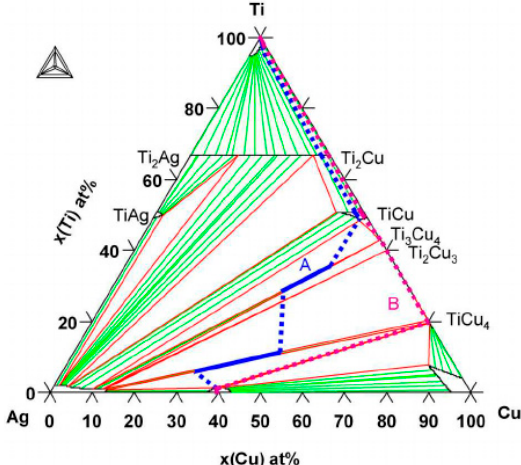
Figure 1. ( a ) Chemical activity of Cu and Ti in intermetallic phases formed as a result of the reaction at 790 °C in pure and ( b ) saturated 40% Ti–Ag in a liquid Cu alloy Reprinted with the permission of [12].